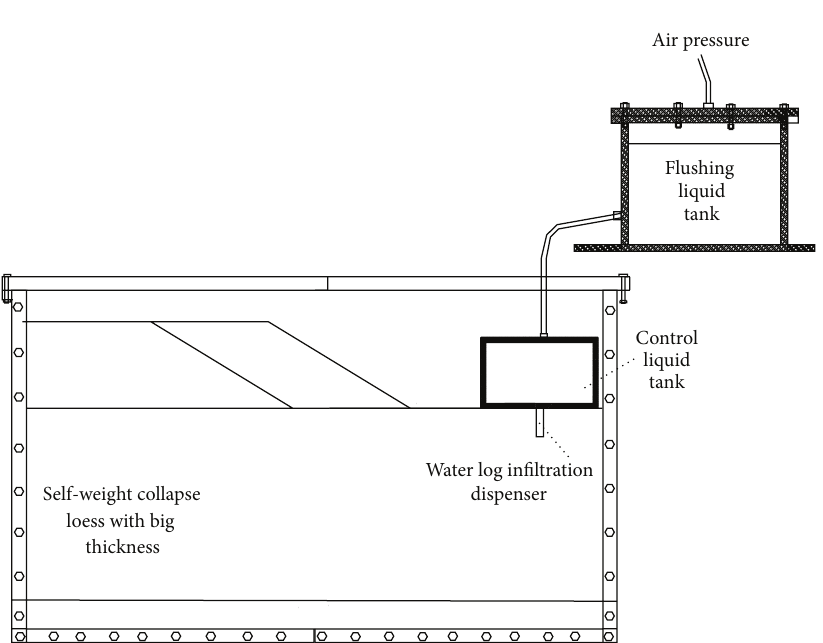
Figure 9: Schematic of centrifuge experiments setup for water log infiltration.